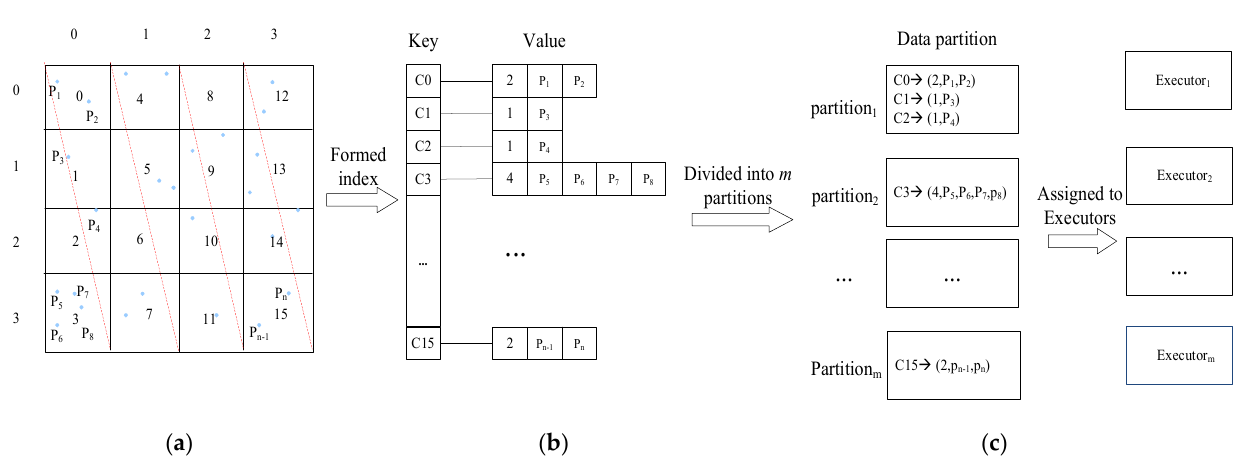
Figure 1. An example of grid index. ( a ) Data space partition; ( b ) grid index; ( c ) index data partition.